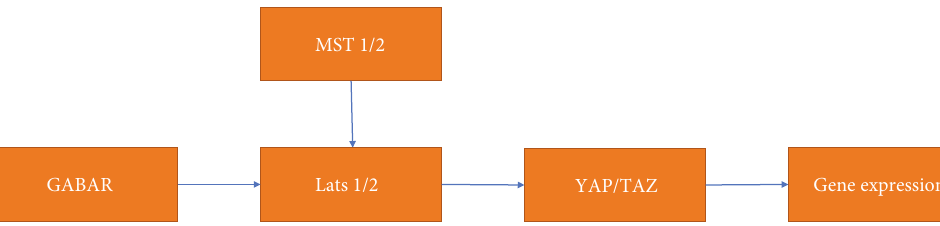
Figure 2: The YAP/TAZ pathway and tumor gene proliferation. The Hippo signaling pathway, also known as the Salvador/Warts/Hippo (SWH) pathway, is named after Hippo (Hpo), a protein kinase in drosophila and a key regulatory factor in the pathway. This pathway is composed of a series of conserved kinases that control organ size by regulating cell proliferation and apoptosis. Once it senses the extracellular growth inhibition signal, it activates a cascade of kinase phosphorylation reactions, culminating in phosphorylation of downstream e ff ector factors YAP and TAZ. Cytoskeleton proteins bind to phosphorylated YAP and TAZ, causing them to remain in the cytoplasm and reduce their nuclear activity, thus achieving regulation of organ size and